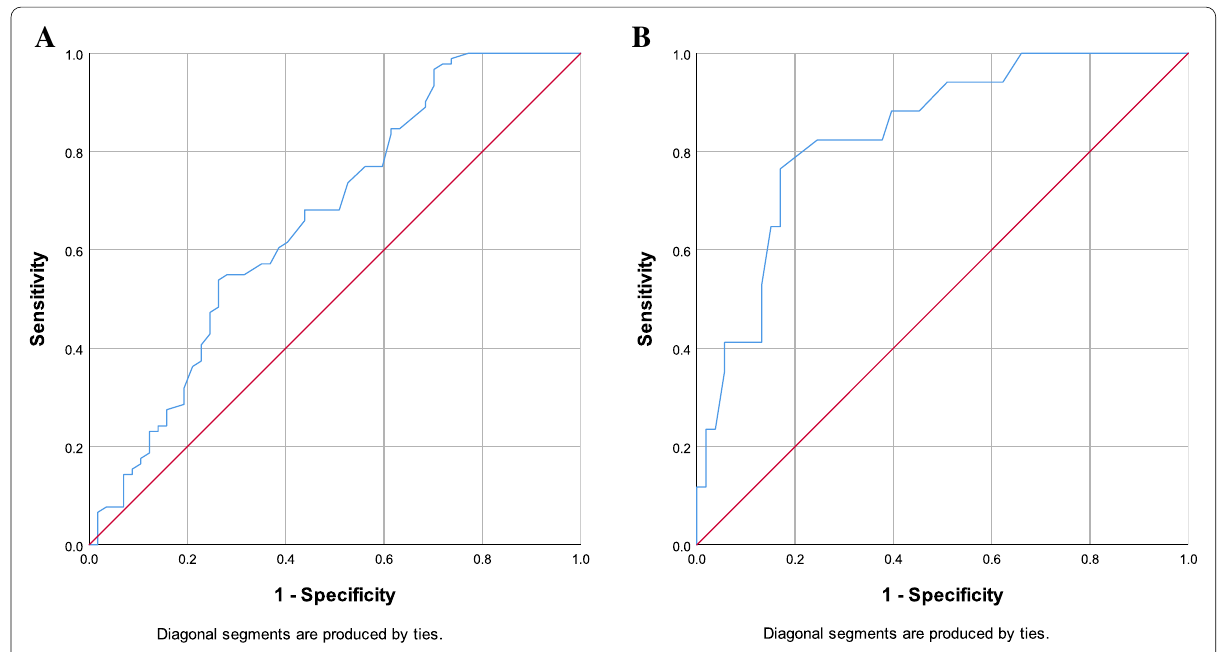
Fig. 1 A ROC curve of FSH for women < 35 years. B ROC curve of AMH for women